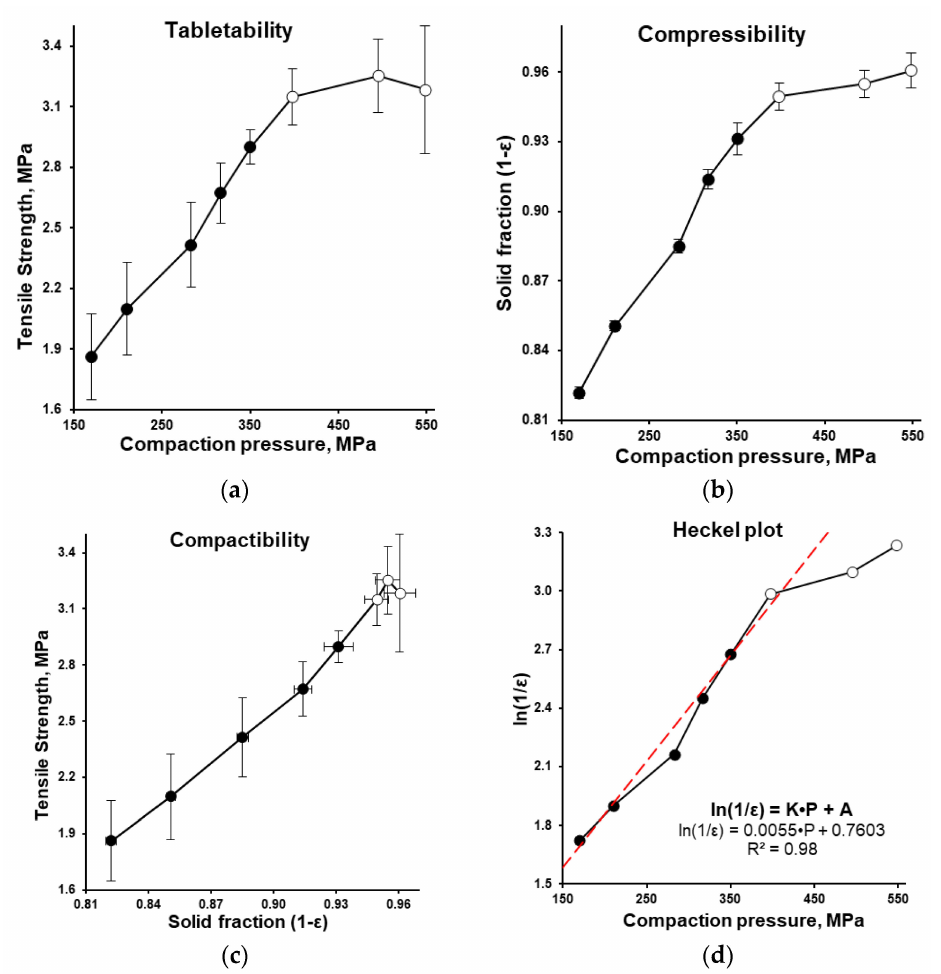
Figure 8. Tabletability ( a ), compressibility ( b ) and compactability ( c ) profiles as well as Heckel plot ( d ) ( n = 10). Empty markers depicted conditions that resulted in the appearance of defective tablets after the friability